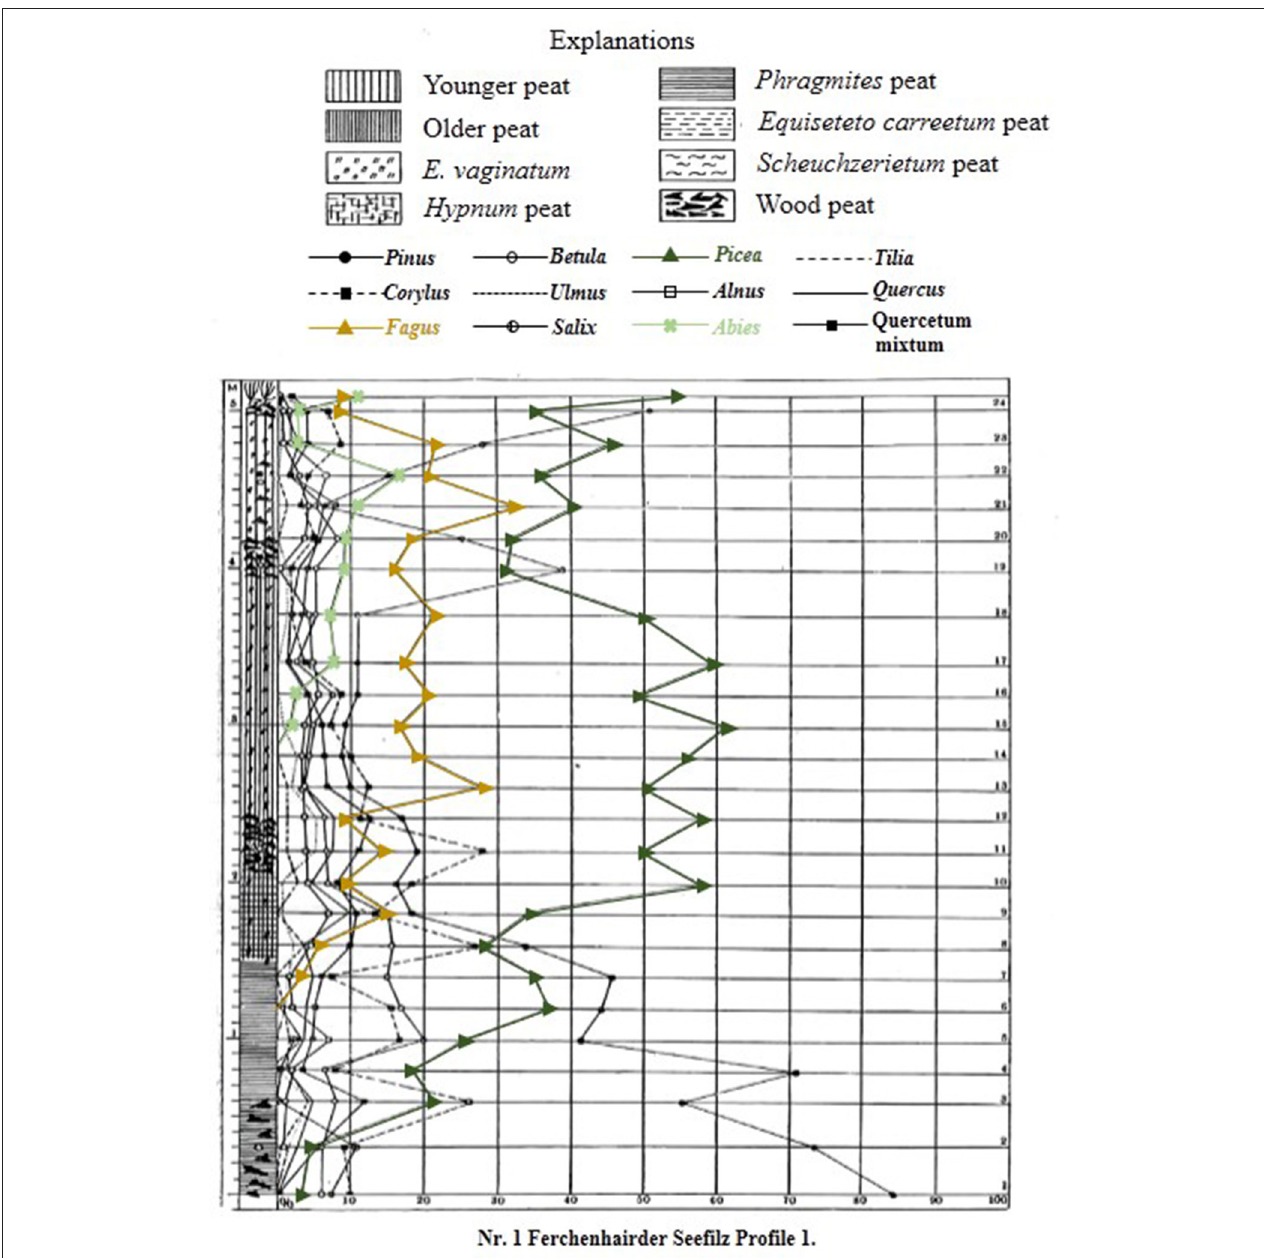
FIGURE 2 | Original pollen percentage diagram of Ferchenhaider Seefilz profile I from the Bohemian/Bavarian Forest region of central Europe. Digitized from Müller (1927), and translated from German into English. Dominant species found in the Bohemian/Bavarian Forests are shown in color; spruce (green line), beech (gold line), and fir (light green